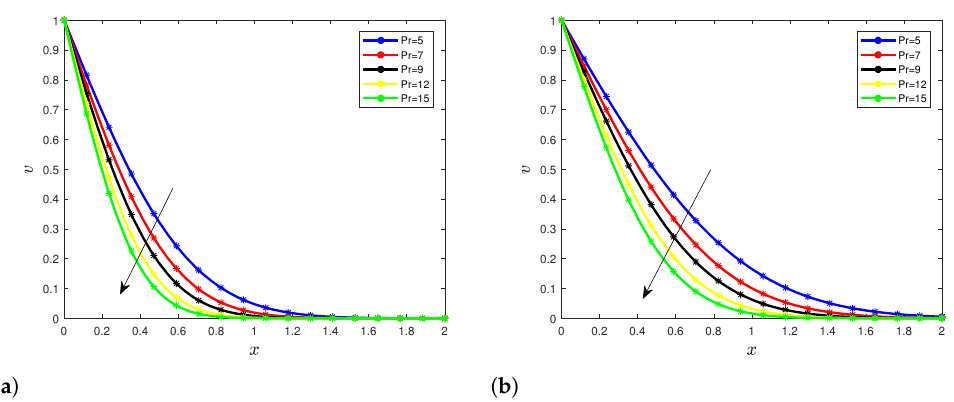
Figure 4. Dynamics of the fractional heat equation with various orders with, respectively, τ = 0.5 ( a ) and τ = 1.5 ( b ) with α = 0.65.